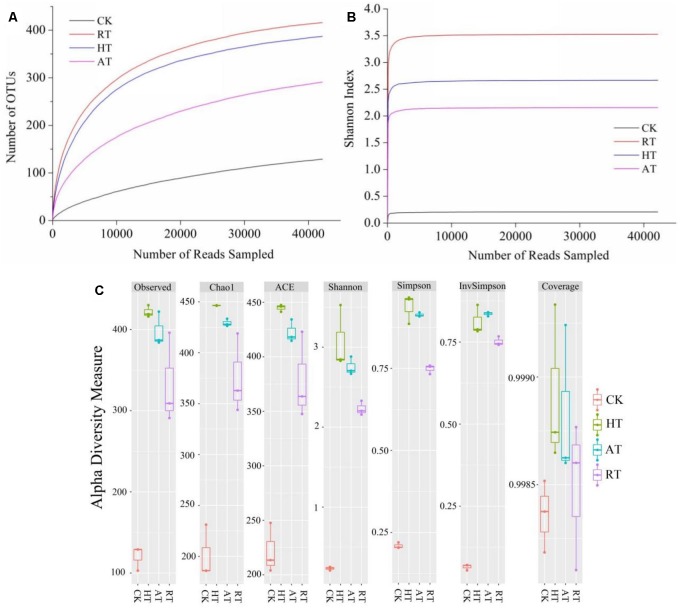
Rarefaction curve (A), Shannon index curves (B), and Alpha diversity (C) of freeze-dried Agaricus bisporus under different storage conditions.